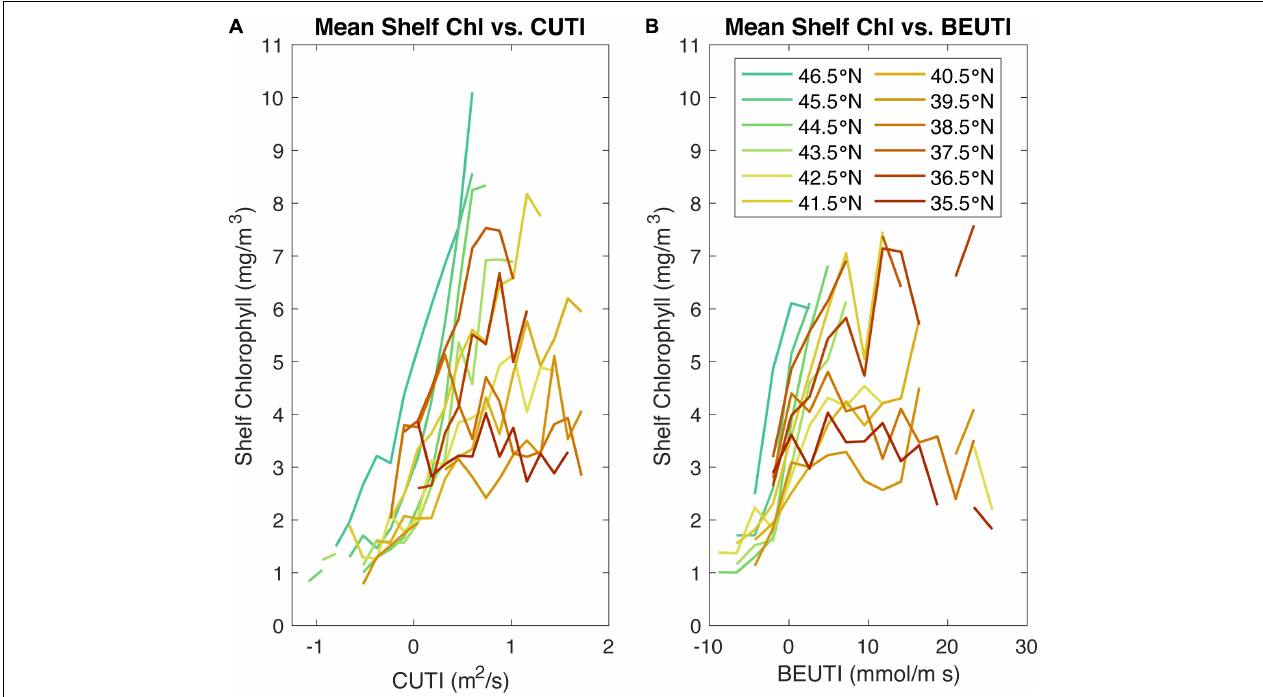
FIGURE 9 | Mean shelf chlorophyll concentration plotted against CUTI ( A ) and BEUTI ( B ), colored by latitude. Similar to the shelf chlorophyll concentration vs. wind stress plots, in these plots, shelf chlorophyll was binned by its corresponding CUTI and BEUTI values, and the mean value and 95% confidence intervals for each bin is calculated. For CUTI, each bin represents 0.14 m 2 /s and for BEUTI, each bin represents 2.3 mmol/s. Bins with a difference between their high and low confidence intervals greater than the CCS-wide mean were ignored.